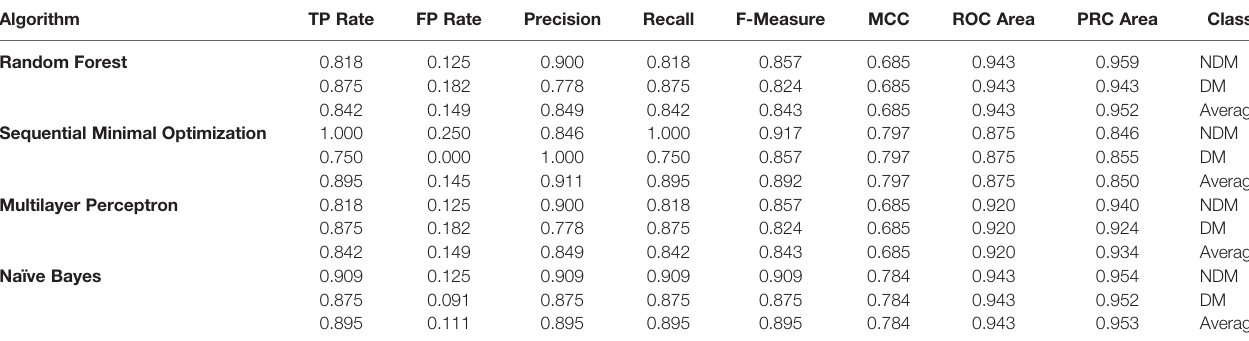
TABLE 4 | Quantitative assessment of the best ranked machine learning algorithms for JAZ-MYC3 hot spots prediction. Algorithm TP Rate FP Rate Precision